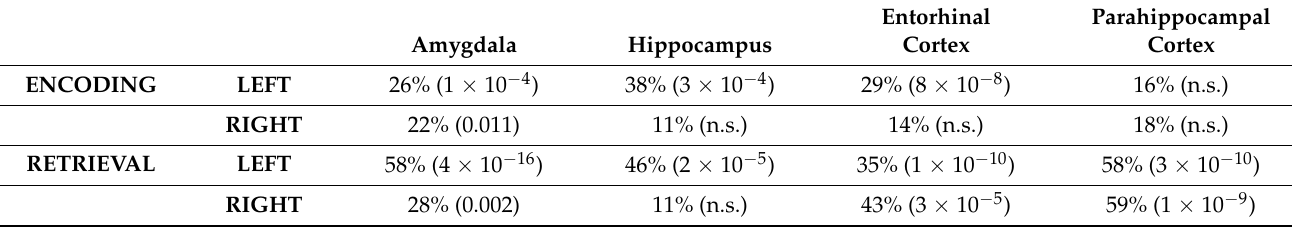
Table 1. Overview of region-specific results of binomial tests.